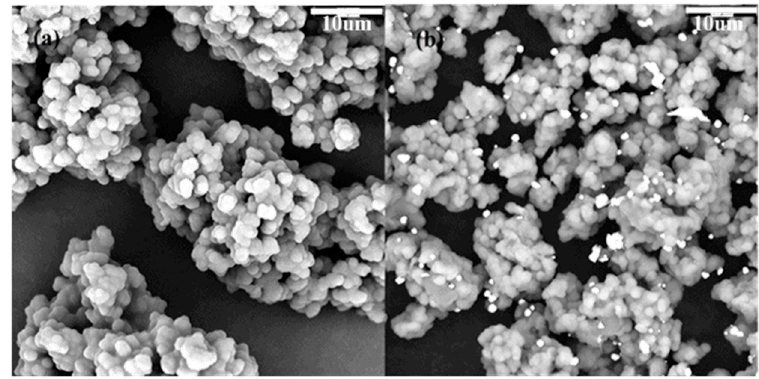
Figure 9. SEM images of TP-AFC before ( a ) and after ( b ) adsorption.